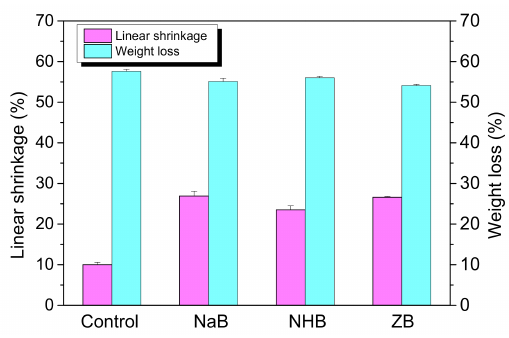
Figure 5. Linear shrinkage and weight loss of the ceramic residues by incorporation of different